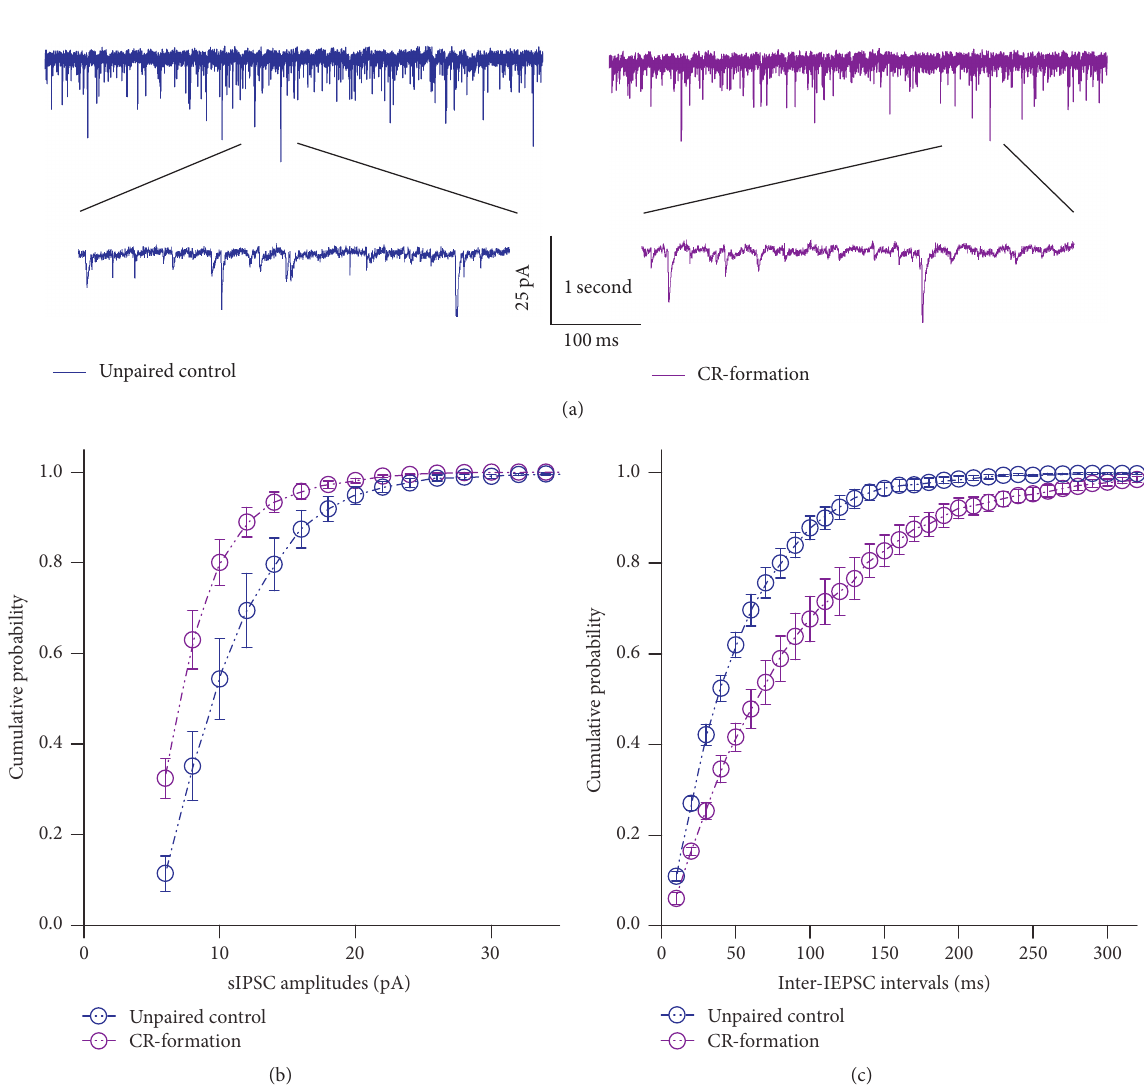
Figure 5: Inhibitory synaptic transmission on barrel cortical pyramidal neurons decreases after pairing WS and OS. Spontaneous inhibitory postsynaptic currents (sIPSCs) were recorded on glutamatergic neurons in cortical slices under voltage-clamp (holding potential at − 65 mV) in presence of 10 𝜇 M CNQX and 40 𝜇 M D-AP5. (a) Traces show sIPSCs recorded on the neurons from controls (dark-blue in left panel) and CR-formation (dark-red in right). The bottom traces present the expanded waveforms selected from top traces. Calibration bars are 25 pA, 1 second (top) and 100ms (bottom). (b) shows cumulative probability versus sIPSC amplitudes from CR-formation (dark-red symbols, 𝑛 = 12 ) and control (dark-blue symbols, 𝑛 = 12 ). (c) shows cumulative probability versus inter-sIPSC intervals from CR-formations (dark-red symbols, 𝑛 = 12 ) and controls (dark-blue symbols, 𝑛 = 12